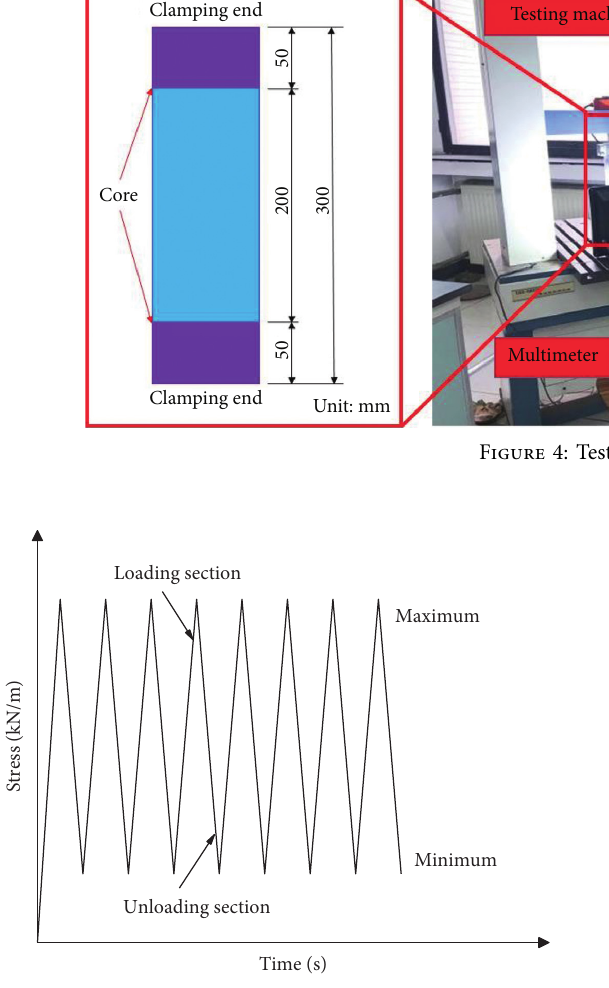
Figure 5: Cyclic tensile loading system.